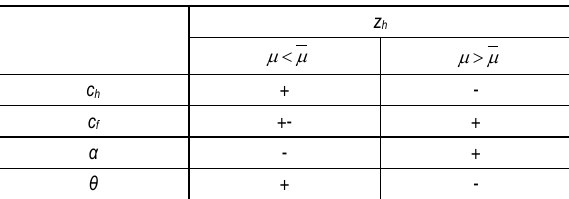
Table 1. Results of comparative statics for